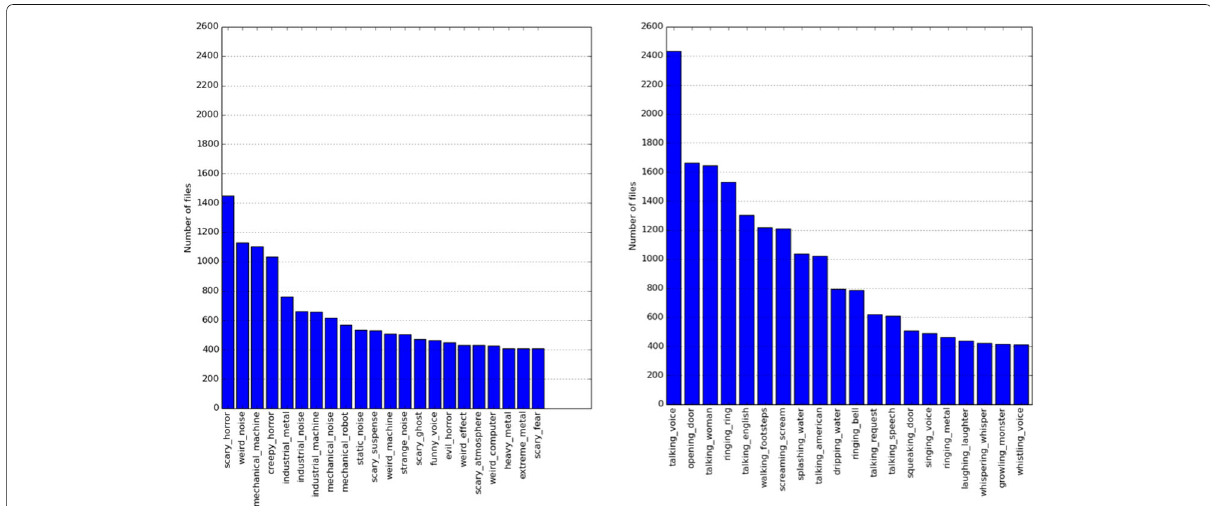
Fig. 4 Number of files per pair. ANPs (left) and VNPs (right) with the largest number of files. Both plots show a decreasing distribution with a long tail trimmed due to space limitations. ANPs show a smoother decrement, which translates to a more uniform number of files per concept pair